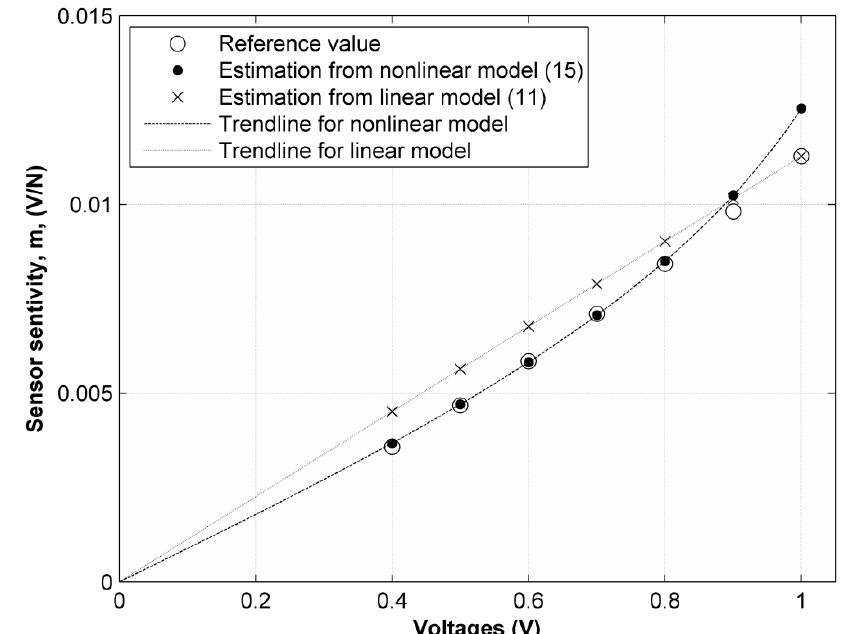
Figure 9. Sensor Sensitivity, m , for different input voltages. The prediction from the linear Equation (11) and the nonlinear Equation (15) models are compared to the reference sensitivity measured at different input